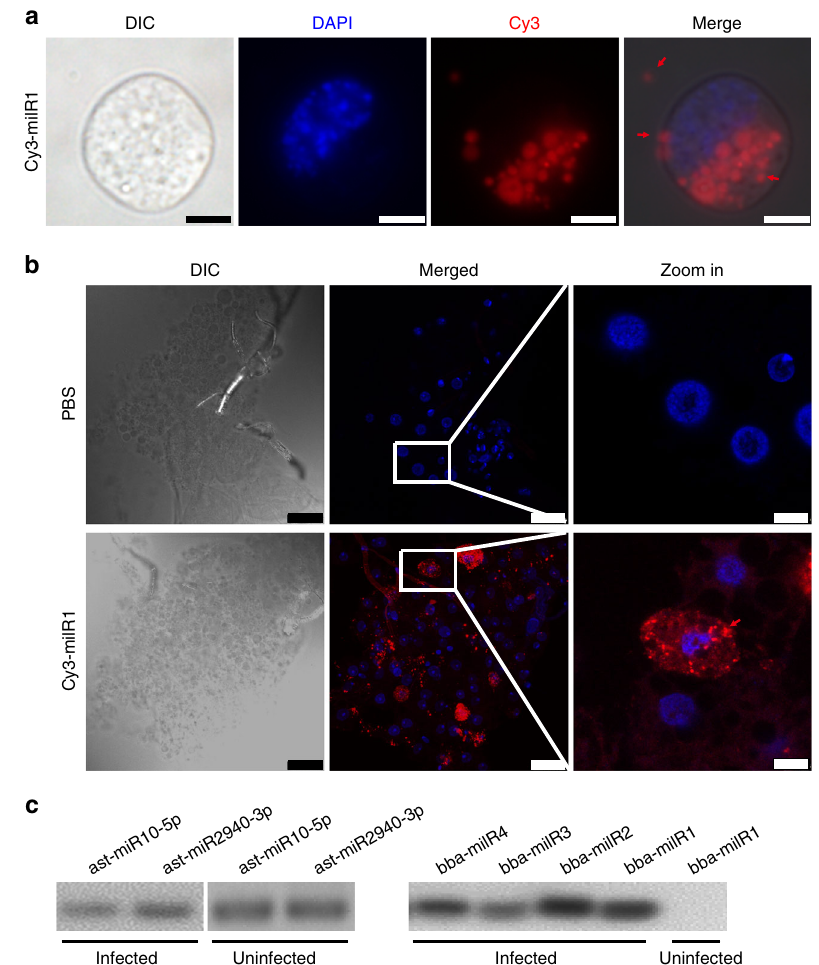
Fig. 2 bba-milR1 enters host cells and binds to mosquito Argonaute 1 (AGO1). a bba-milR1 enters C6/36 mosquito cells via vesicles that were present outside the cells, on the cell surface or in the cytoplasm. Cy3- fl uorescein-labeled bba-milR1 (2 μ M) was added to C6/36 cells, incubated for 24 h, then washed with PBS, fi xed in 4% paraformaldehyde, and stained with DAPI. DIC, differential interference contrast microscopy; red, Cy3; blue, DAPI. Scale bars, 5 μ m. b bba-milR1 is translocated into adult mosquito fat body cells. Cy3-labeled bba-milR1 (20 μ M) or PBS was injected into the hemocoel of A, stephensi female mosquitoes. The fat body was dissected 24 h later, washed with PBS, fi xed in 4% paraformaldehyde, followed by nucleic acid staining with DAPI. Scale bars in DIC and merge: 25 μ m; scale bars in zoom in: 5 μ m. Images were acquired by confocal microscopy. c RT-PCR detection of AsAgo1- bound sRNAs. Fungal milRNAs are detected in the AsAGO1-RIP (RNA immunoprecipitation) fraction from the B. bassiana- infected A. stephensi mosquitoes that were collected at 36hpi, 60 hpi and 84 hpi, mixed and homogenized in ice-cold RIP lysis buffer, but not in the uninfected mosquitoes. AGO1-bound sRNAs were pulled down from fat body homogenates with antibody AsAGO1-linked magnetic beads. RNA was then released from AGO1-RIP fraction after digestion with protease K. Uninfected mosquitoes mixed with B. bassiana ARSEF252 mycelia were used as a control to rule out any nonspeci fi c association between AGO1 and milRNAs during the experimental process. The AGO1-associated sRNAs were detected by RT-PCR. As a positive control, two A. stephensi miRNAs ast-miR10-5p and ast-miR2940-3p were detected in AsAGO1-RIP samples. Source data are provided as a Source Data fi